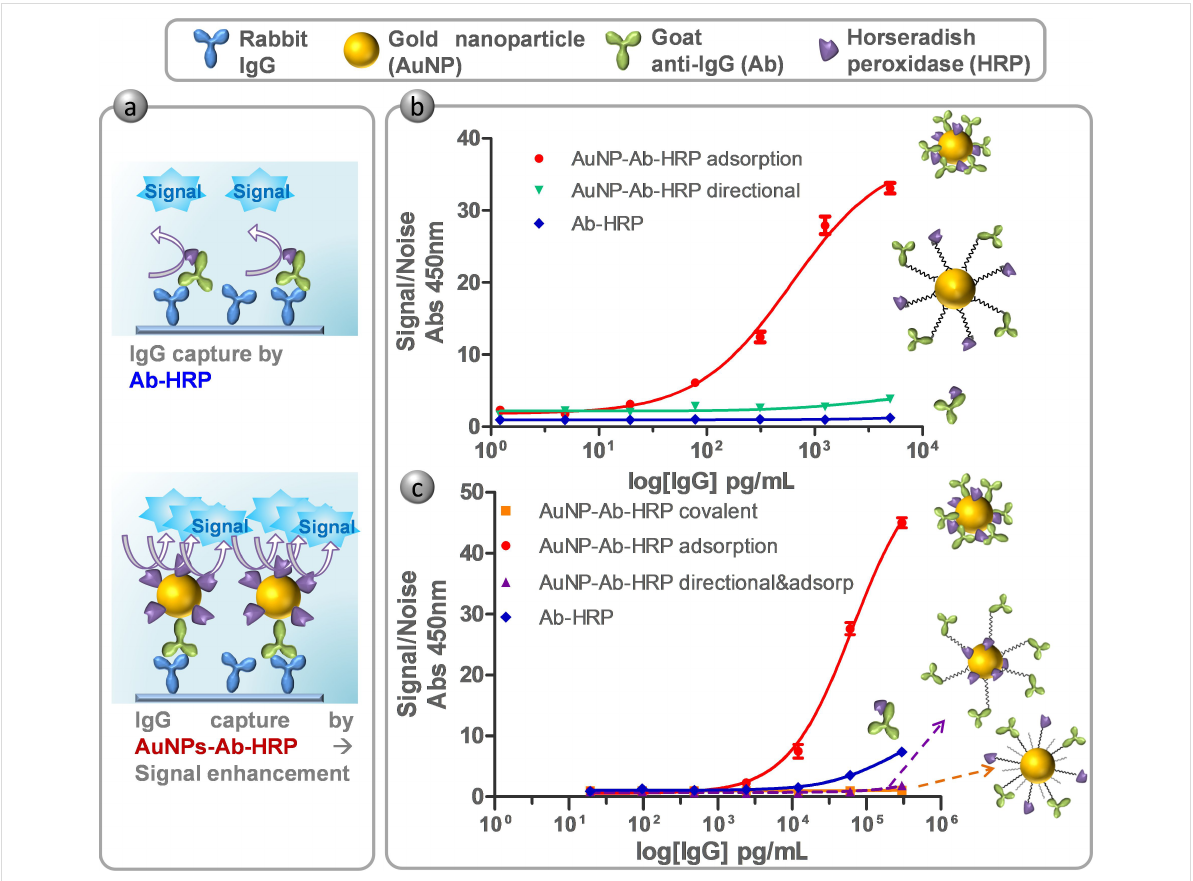
Figure 3: (a) Schematic representation of model ELISA and the basis of enhancement by means of AuNP probes. (b) Result of ELISA comparing AuNP probes prepared by adsorption (red curve), directional conjugation (green) and labelled secondary antibody (Ab-HRP, blue). (c) Result of ELISA comparing AuNP probes prepared by adsorption (red), covalent (orange), directional and adsorption (purple) and Ab-HRP (blue). Results are represented as the S/N ratio which represents the absorbance at 450 nm of samples in the presence and absence of IgG,